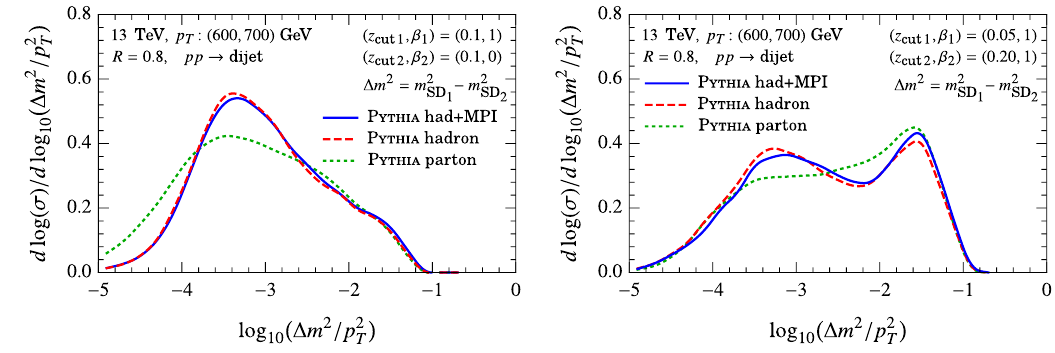
Figure 16 . Collinear Drop distributions with ( z cut1 ; (cid:12) 1 ) = (0 : 1 ; 1) and ( z cut2 ; (cid:12) 2 ) = (0 : 1 ; 0) (left panel) and ( z cut1 ; (cid:12) 1 ) = (0 : 05 ; 1) and ( z cut2 ; (cid:12) 2 ) = (0 : 2 ; 1) (right panel) from Pythia simulations. Results at parton and hadron (with and without multi-parton interactions) levels are provided.